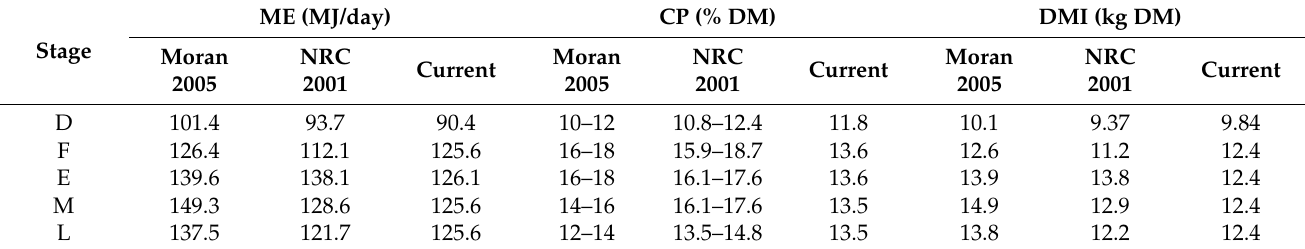
Table 5. A comparison of the amount of metabolisable energy (ME; MJ/day), crude protein (CP; % DM), and daily DM intake (DMI; kg DM) of dairy cows in the current study compared to guidelines published by NRC [29] and Moran [30].